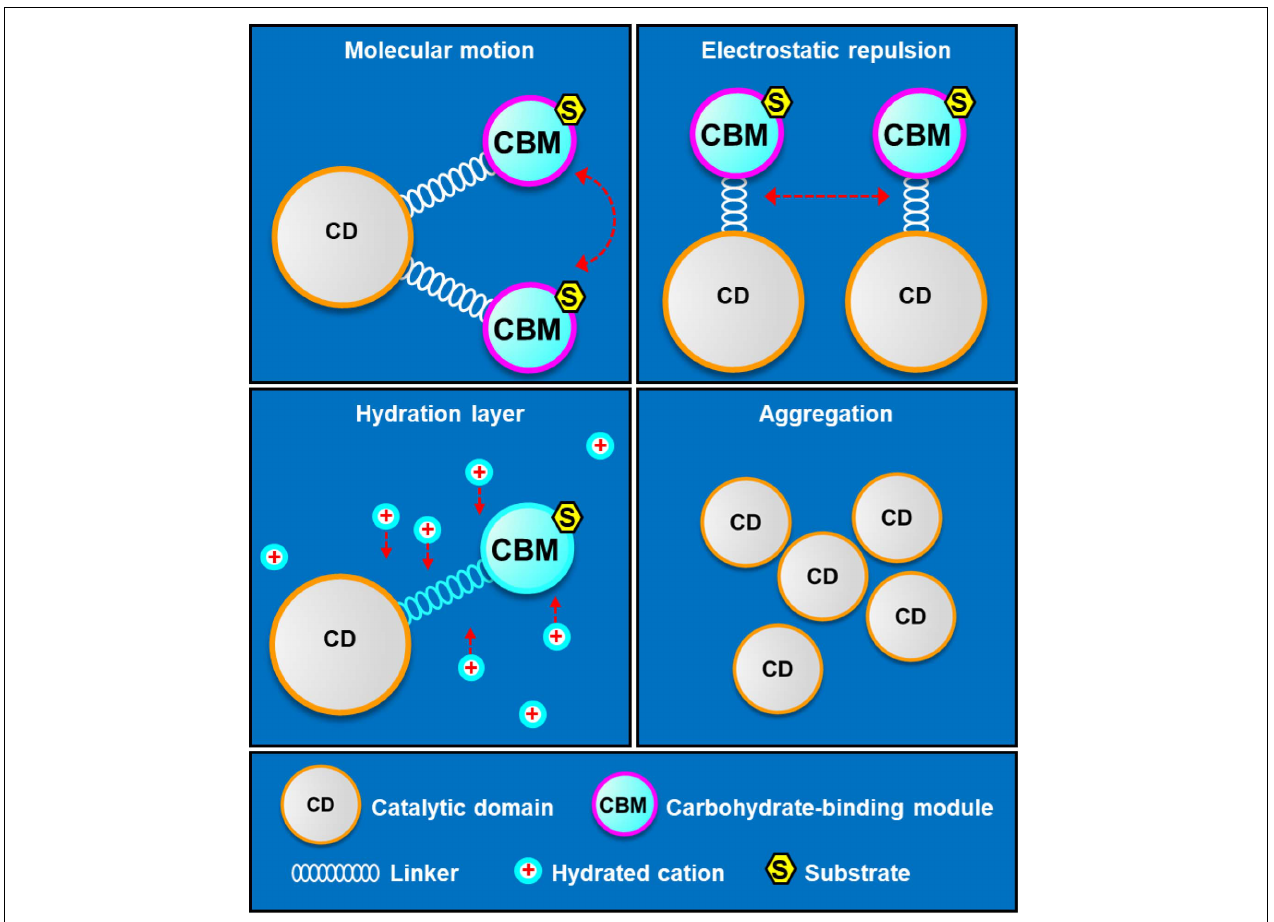
Retain ∼ 78% of its maximum Retain ∼ 80% of its maximum activity at 4 ◦ C activity at 20 ◦ C activity at 20 ◦ C − 4.1